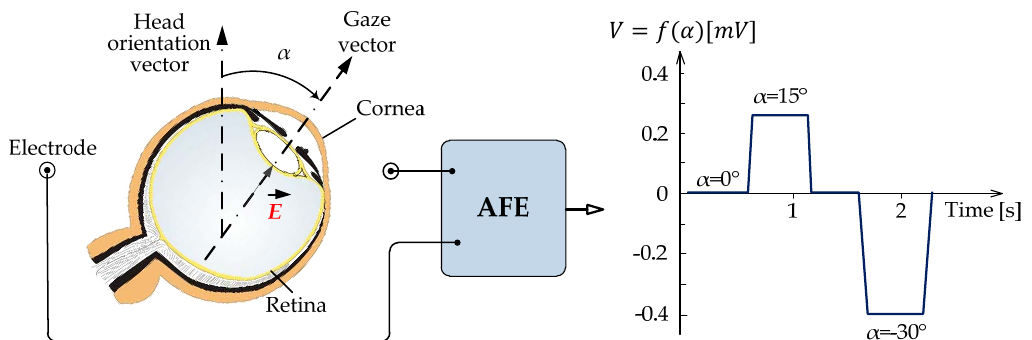
Figure 1. Ideal representation of the foundation of the electrooculogram (EOG) when modeling the eye as a measurable dipole using surface electrodes. These electrodes make up the input to the Analog Front ‐ End (AFE) to record the potential difference generated by eye movement.